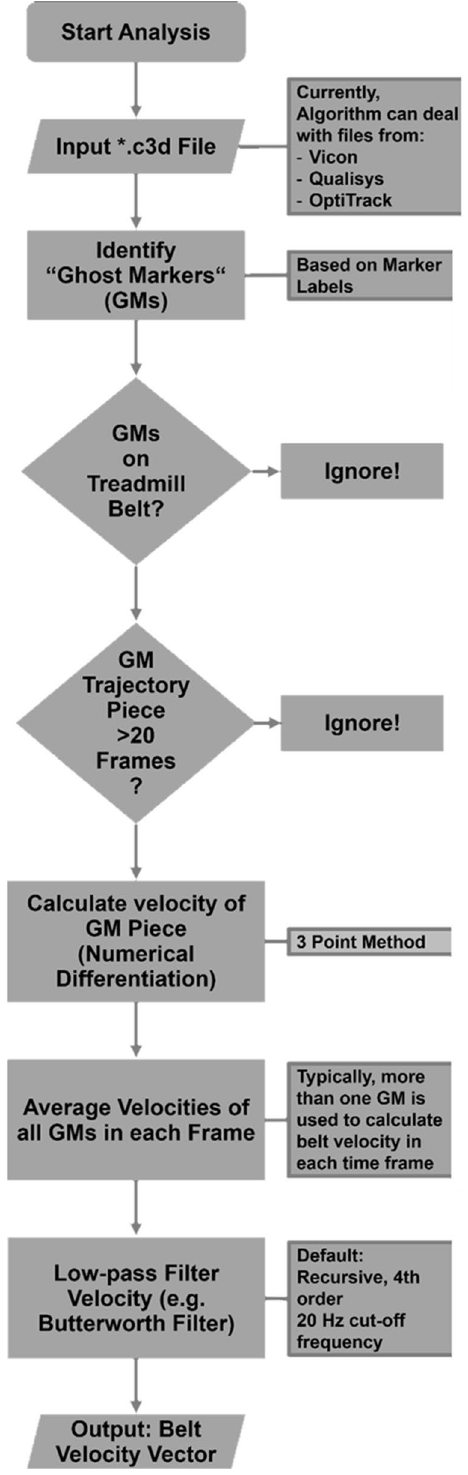
Figure 2. Description of the belt velocity